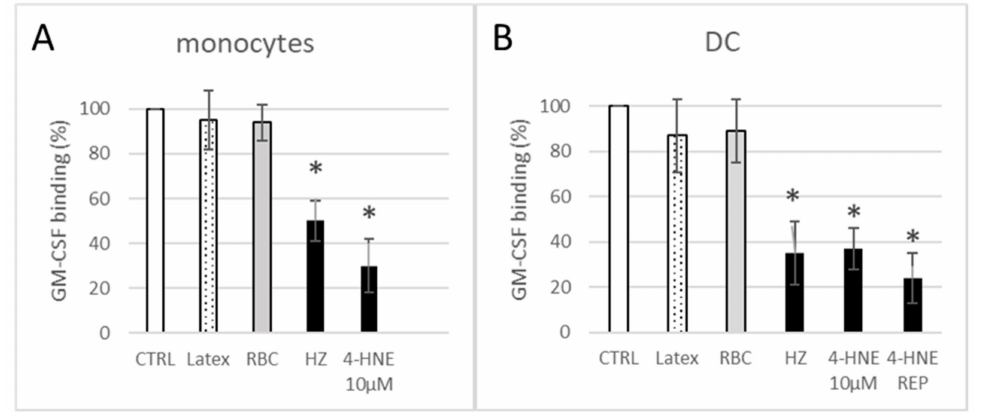
Figure 4. Inhibition of GM-CSF binding in HZ-fed or 4-HNE-treated monocytes and DC. Monocytes were kept as untreated controls (CTRL) or incubated with inert latex beads (Latex), erythrocytes (RBC), HZ, 10 µ M 4-HNE as single dose (4-HNE 10 µ M), or 1 µ M 4-HNE repetitively added every 2 days (4-HNE REP), always before GM-CSF supplementation. Monocytes unstimulated by GM-CSF were analysed for GM-CSF-FITC binding after 24 h ( A ) or were differentiated to DC, and GM-CSF binding assay was performed with DC after 7 days of differentiation ( B ). For assessment of GM-CSF binding, cells were incubated with fluorescent GM-CSF-FITC, washed, and analysed for fluorescence by flow cytometry. Percentage of GM-CSF-FITC binding in treated cells vs. untreated CTRL cells is shown. Absolute values for untreated controls (CTRL) were 29 ± 6 MFI in monocytes and 16 ± 4 MFI in DC. Means ± SE of 3 independent experiments with monocytes from 3 donors are shown. The significance of differences (* p < 0.01) between controls and HZ- or 4-HNE-treated cells is